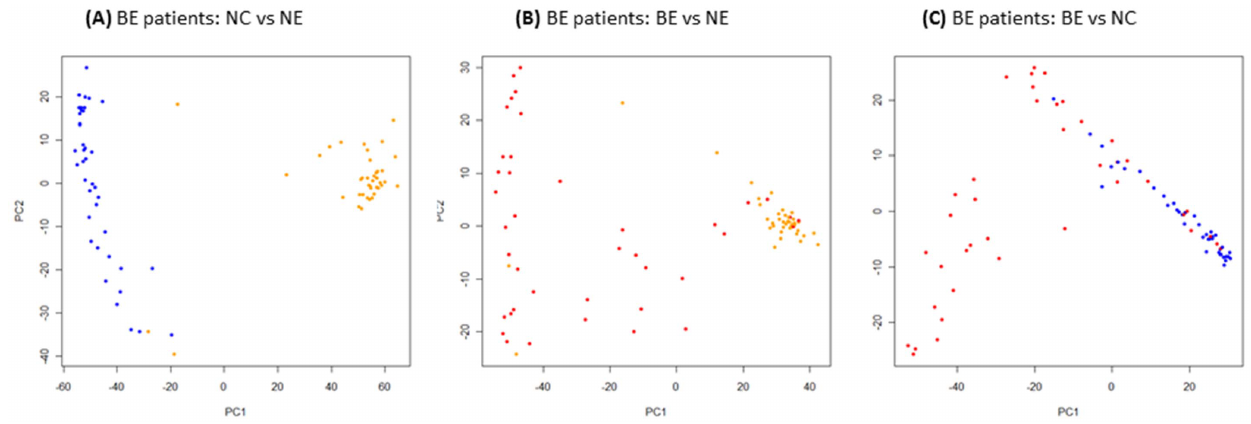
Figure 1. PCA analyses of differentially-expressed probes ( $ 2 fold change in expression and P , 1.12E-06) between matched BE, NE, and NC tissues from BE patients. PCA was applied to each set of differentially-expressed probes to reduce the dimensionality of the microarray data with respect to individual samples. Phenotypic subgroups or tissues (BE, NE, and NC) can be differentiated from each other in BE patients, although there is some mixing of the phenotypes, particularly between BE and NC, which are more similar in terms of gene expression profiles. Color key: Blue=NC, Yellow=NE, Red=BE.